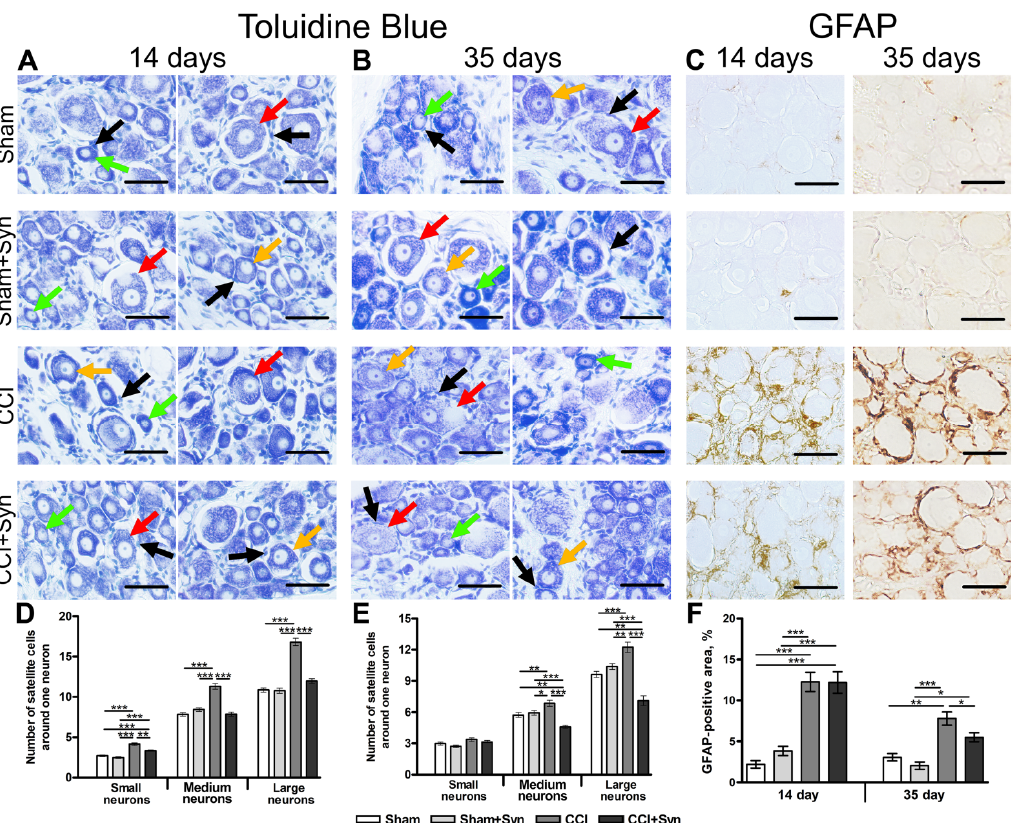
Figure 4. Neuro-glial index in the ipsilateral dorsal root ganglia (DRG). Representative images of ( A , B ) satellite glial cells (black arrows) around small (green arrows), medium-sized (orange arrows), and large (red arrows) neurons, ( C ) glial fibrillary acidic protein-(GFAP-) positive cells. Scale bar is 50 µm. ( D ) Neuro-glial index in the ipsilateral DRG 14 days post-surgery, mean ± SEM, n = 7 (number of animals/group) *** p < 0.001 (one-way ANOVA, post-test Tukey). ( E ) Neuro-glial index in the ipsilateral DRG 35 days post-surgery, mean ± SEM, n = 7 (number of animals/group) * p < 0.05, ** p < 0.01, *** p < 0.001 (one-way ANOVA, post-test Tukey). ( F ) The staining area (% of total